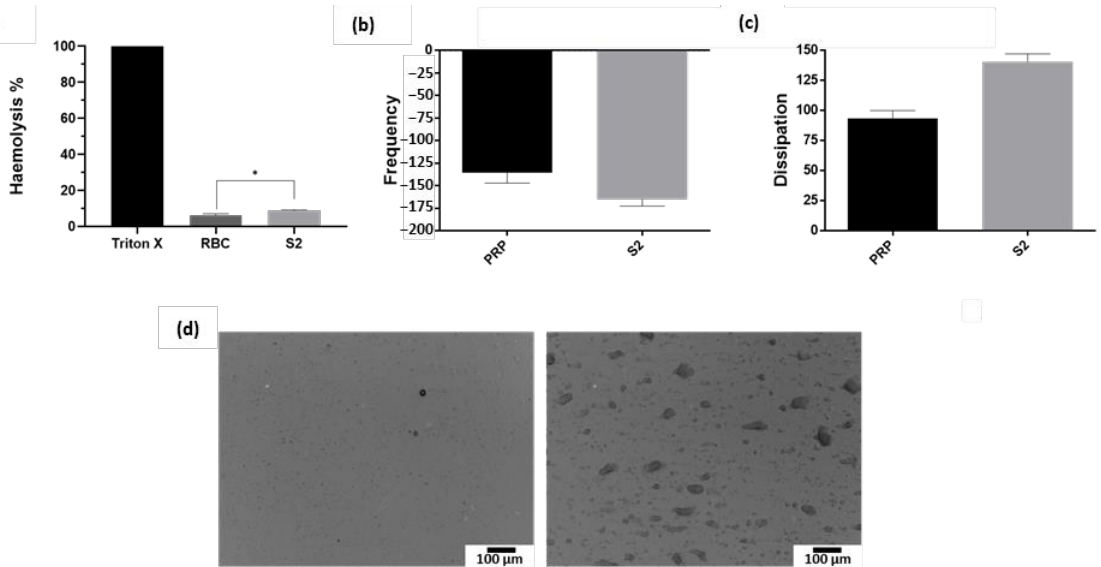
Figure 3. Haemocompatibility assessment of the developed nanomaterials. ( a ) Haemolysis induced by S2 nanoparticles compared to red blood cells (RBC) in the absence of nanoparticles. Triton X-100 was used as a positive control. Data are expressed as means ± s.d. Asterisks indicate significant differences ( p < 0.05) when the t-test was applied. ( b ) Quantitative analysis of the effect of platelet-rich plasma (PRP) in the absence or presence of S2 nanoparticles on the frequency of the quartz crystal, as measured by the quartz crystal microbalance (QCM-D) (n = 2). ( c ) Quantitative analysis of the effect of PRP in the absence or presence of S2 nanoparticles on the energy dissipation, as measured by the QCM-D (n = 2). ( d ) Representative micrographs of the surface of fibrinogen-coated polystyrene-coated quartz crystals as viewed by optical microscopy, showing platelet aggregates following the perfusion of PRP in the absence (image on the left) or presence (image on the right) of S2 nanoparticles.